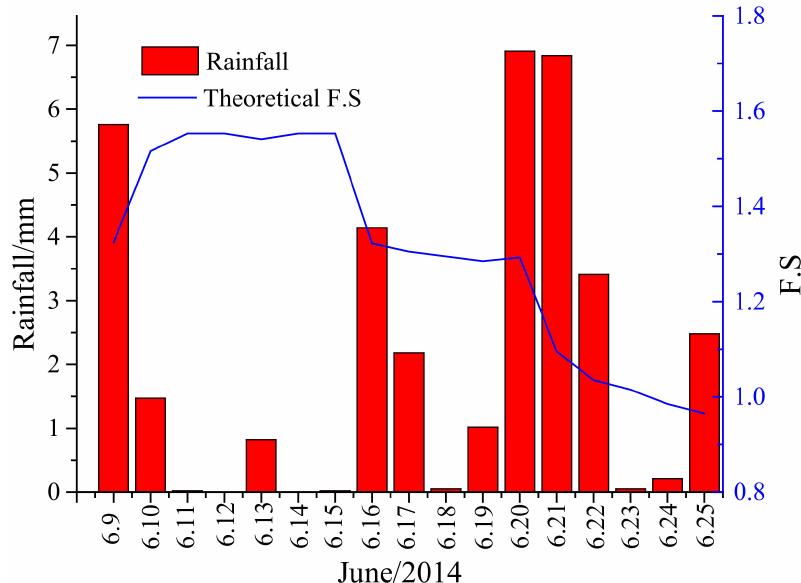
Figure 14. Theoretical F.S during rainfall in June 2014.